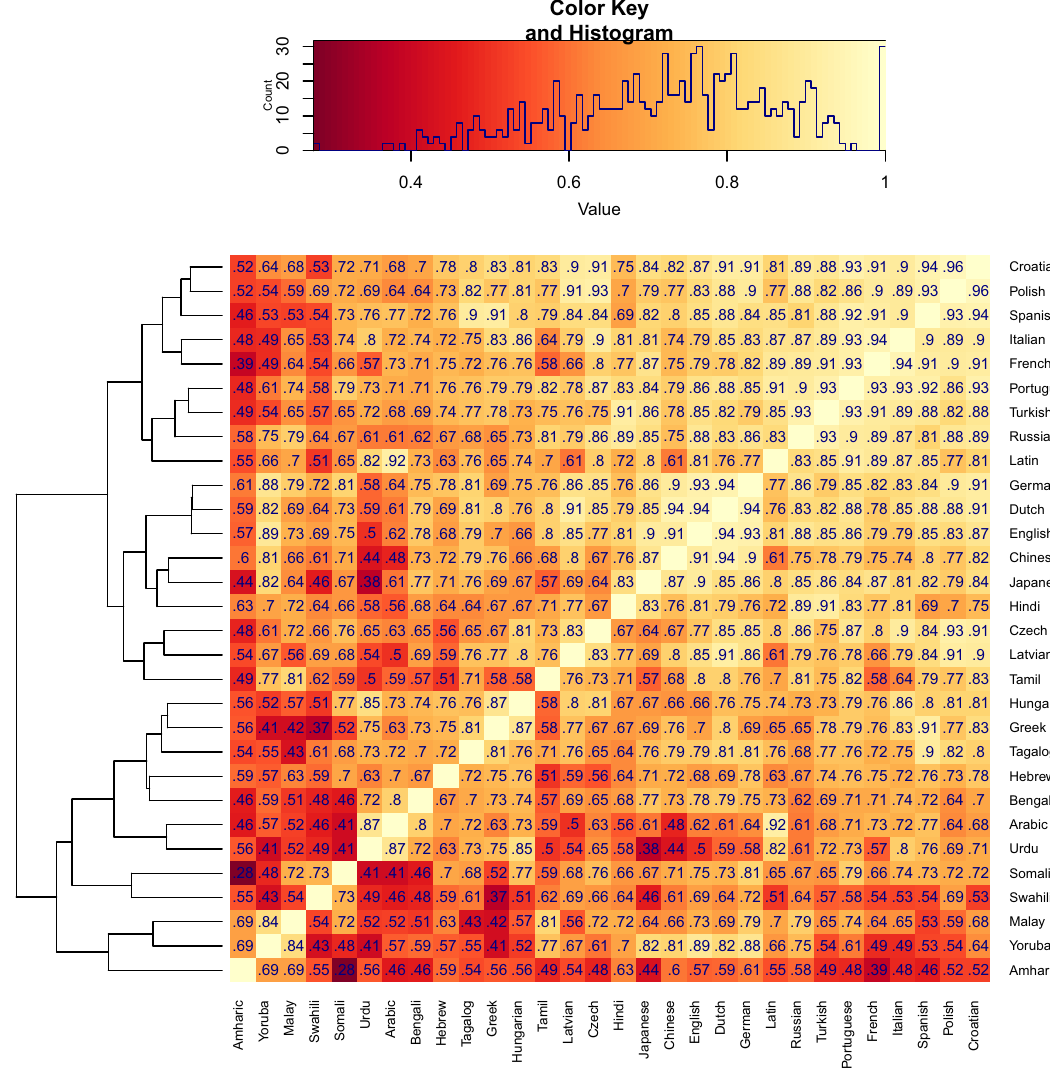
Figure 2. Between-language correlations of the logarithmic word frequencies per million, for the 25 words referring to body parts in Penfield and Boldrey 16 . The dendogram on the left side groups languages by their correlational patterns with other